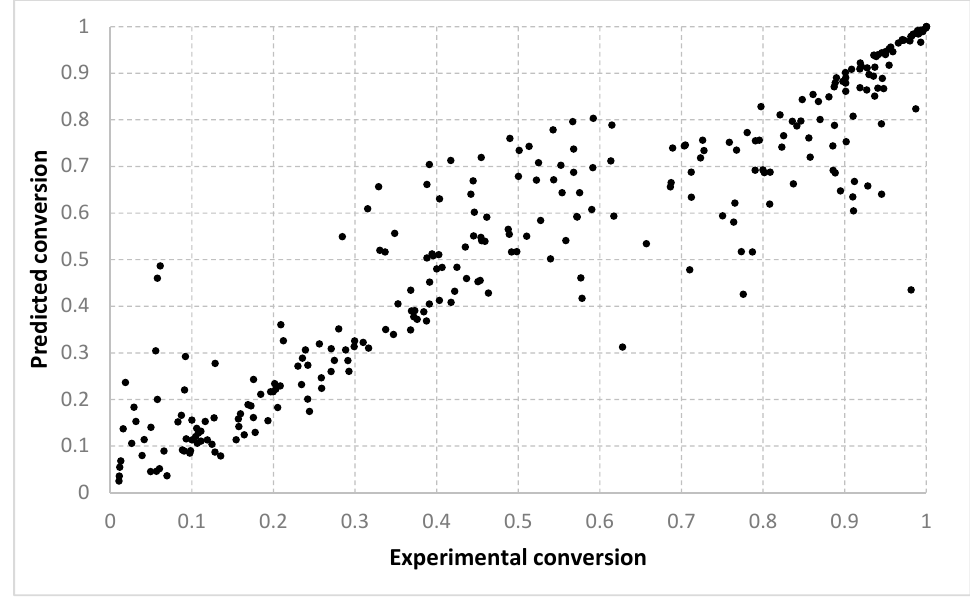
Figure 5. Predicted conversion with the LMNNR-AGD algorithm versus experimental conversion, setting 2, with data split into 10% for training and 90% for testing.